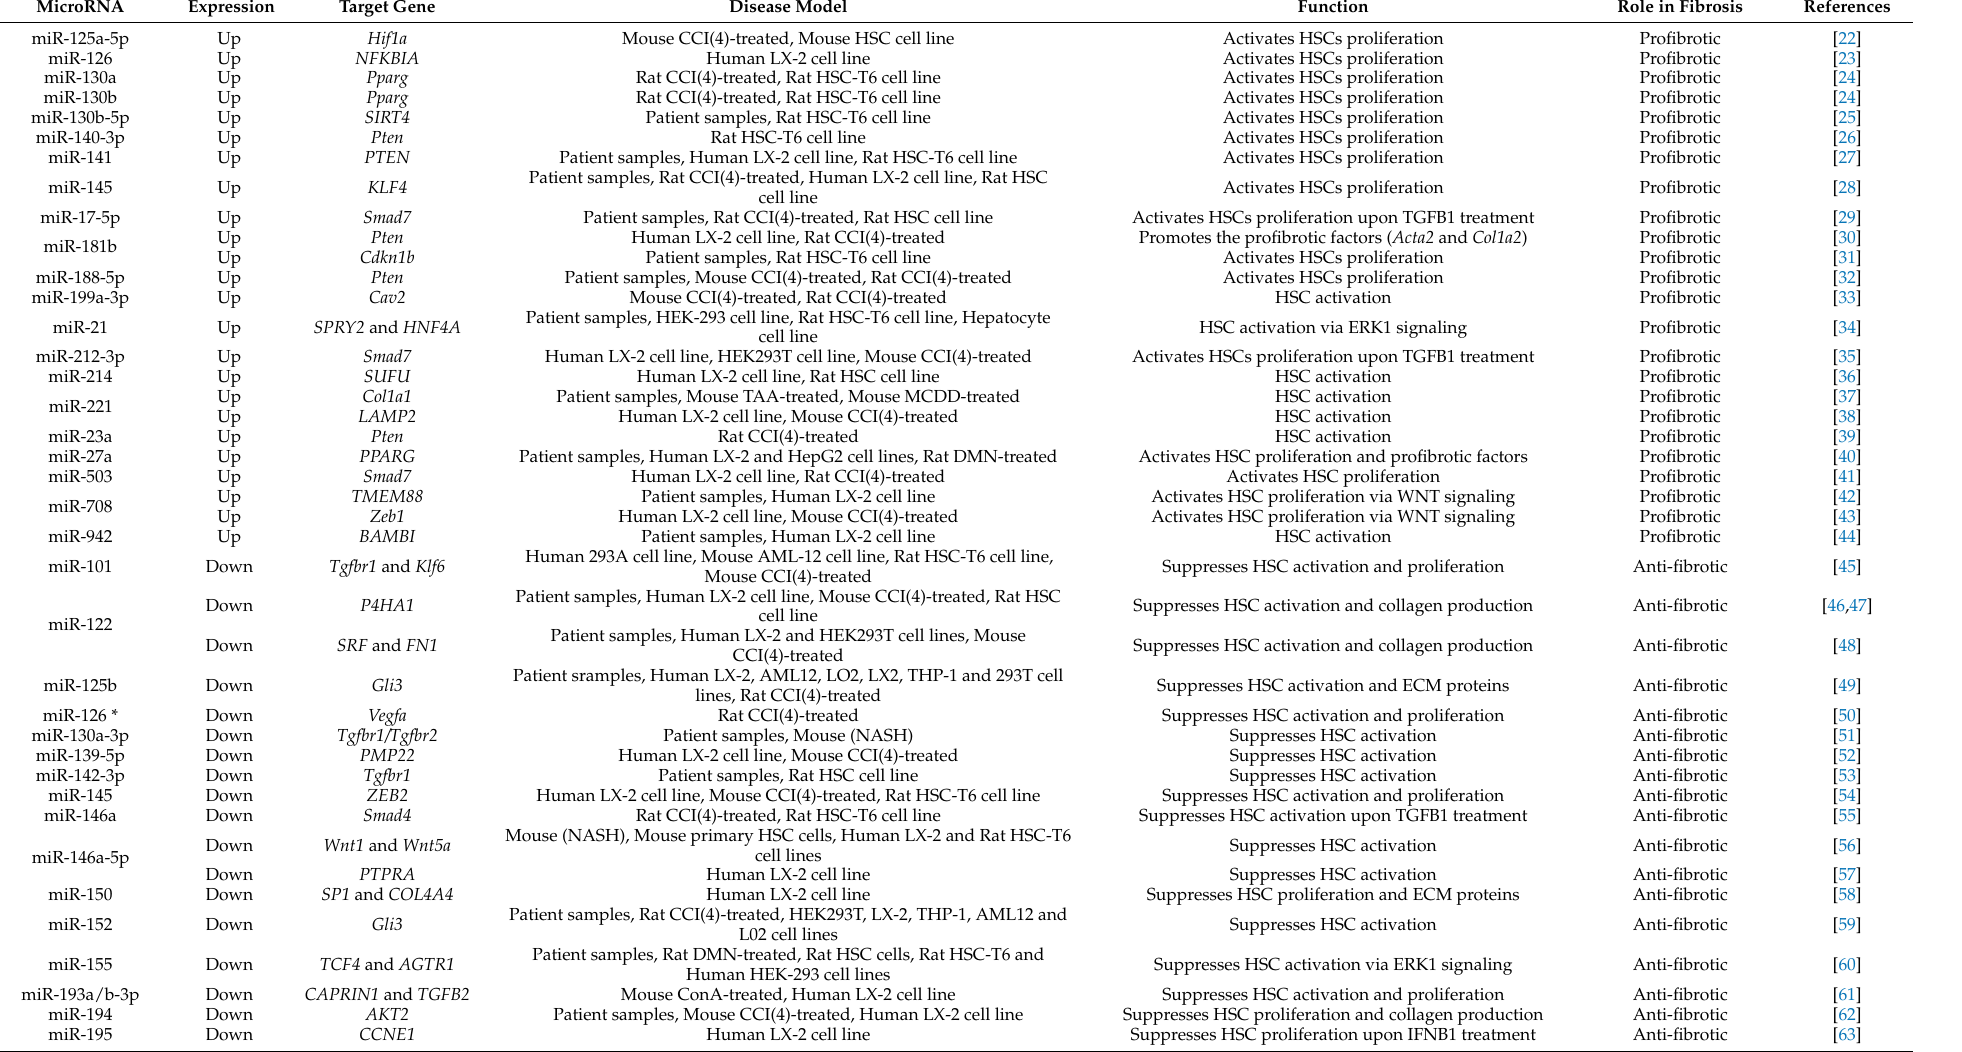
Table 1. Summary of microRNA involved in human hepatic stellate cells (HSC) activation in